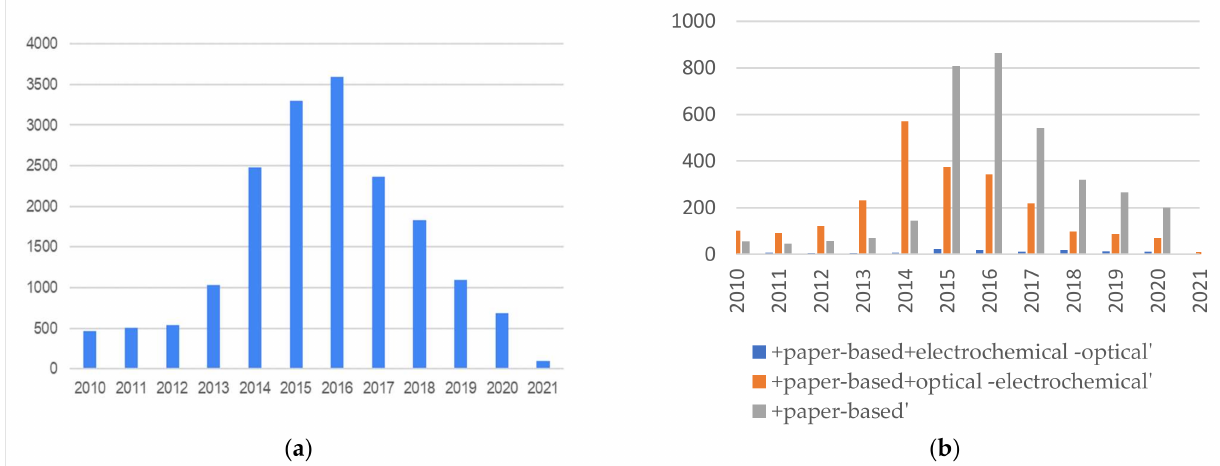
Figure 3. ( a ) Patent applications “biosensor + smartphone + poc(point-of-care)”; ( b ) Patent applica- tions for electrochemical, paper-based, and optical smartphone based